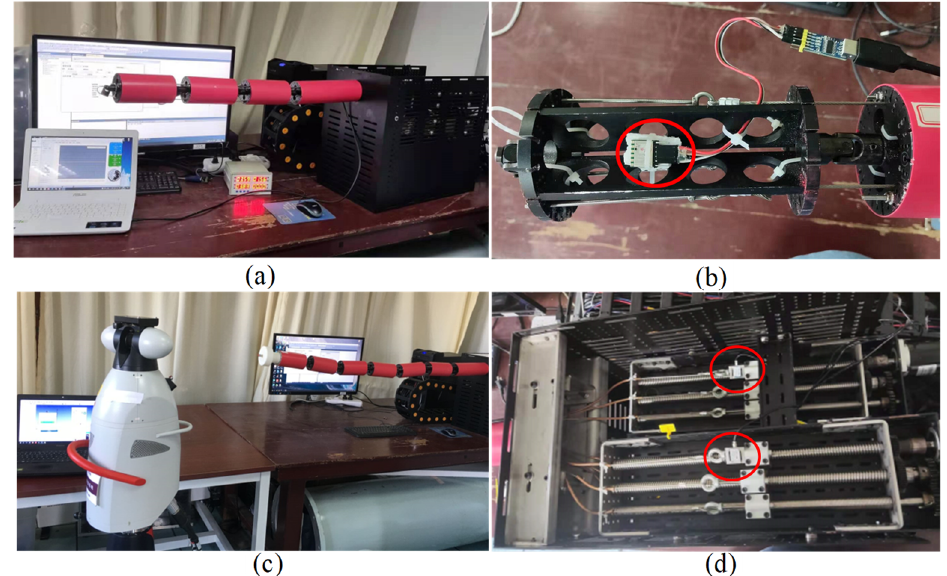
Figure 11. SAM prototype test. ( a ) Single-joint group prototype. ( b ) Gyro angle sensor installation position. ( c ) Laser tracker end position calibration. ( d ) Force sensor installation position.